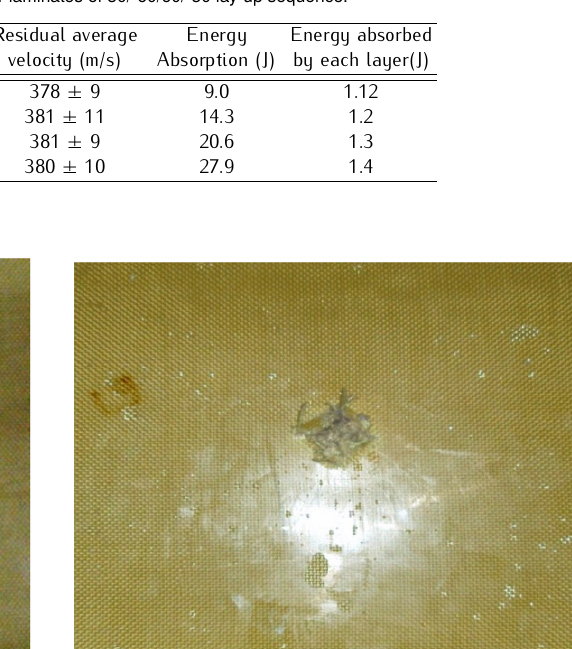
Table 5. Initial and residual velocities for laminates of 30/-60/60/-30 lay-up sequence.